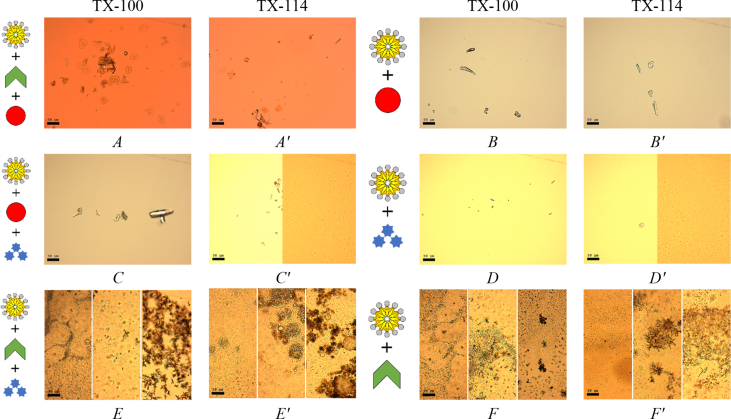
Effect of one or two components removing in the micellar solution. The effect of NaCl (A, A′), NaCl and BPhen (B, B′); BPhen (C, C′), BPhen and FeSO4 (D, D′); FeSO4 (E, E′), FeSO4 and NaCl (F, F′) removing. Scale bar is 50 μm.